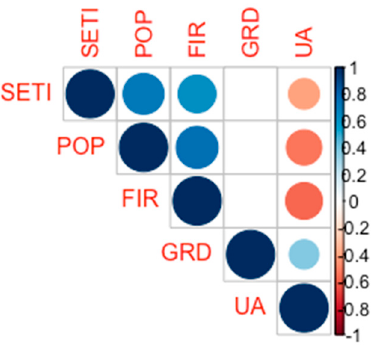
Figure 5. Correlation between SETI and urban characteristics.